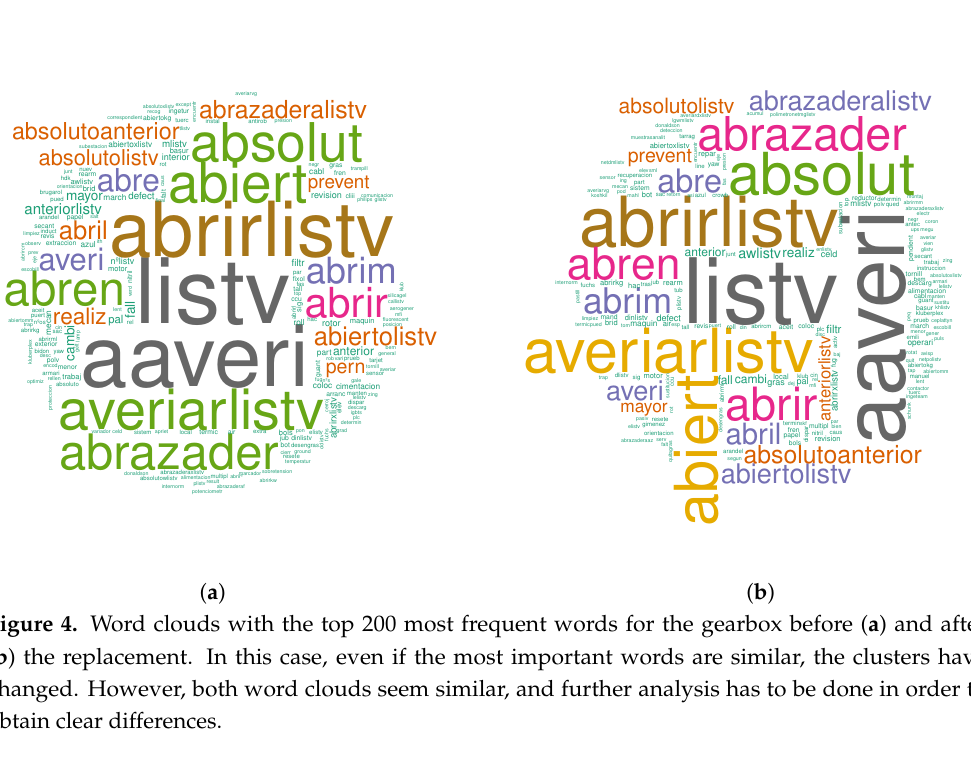
Figure 3. Word clouds with the top 200 most frequent words for the generator before ( a ) and after ( b ) the replacement. Notice that the most important words (the biggest ones) have changed. For example, the word realiz (to do something) is no longer the most important in ( a ); or the word manten (maintenance) appears before but not after.